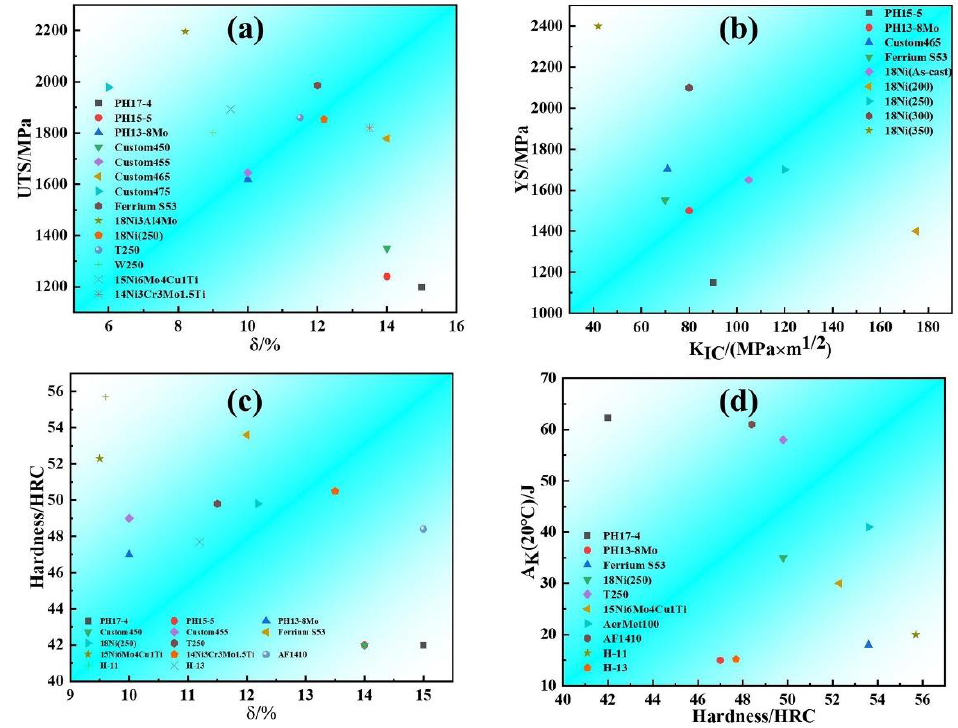
Figure 9. Mechanical properties of typical precipitation hardened stainless steel [135–138]: ( a ) Ulti- mate tensile strength-elongation; ( b ) yield strength-fracture toughness; ( c ) hardness-elongation; ( d ) impact work-hardness. Table 4. Corrosion properties of PHSS after various heat treatment processes [113,139 – 144].